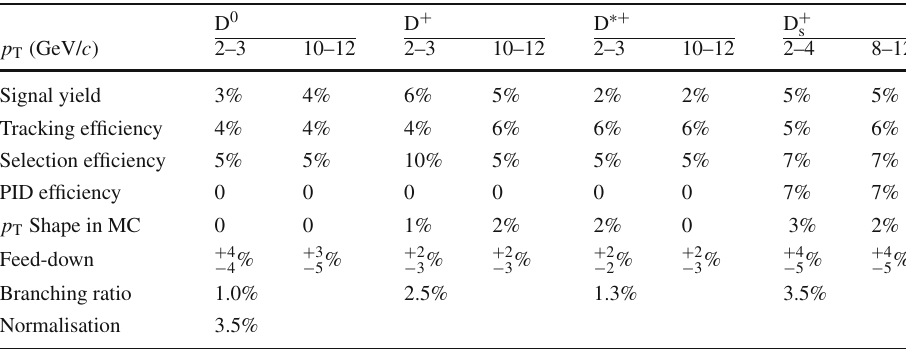
Table 1 Summary of relative systematic uncertainties for two p T